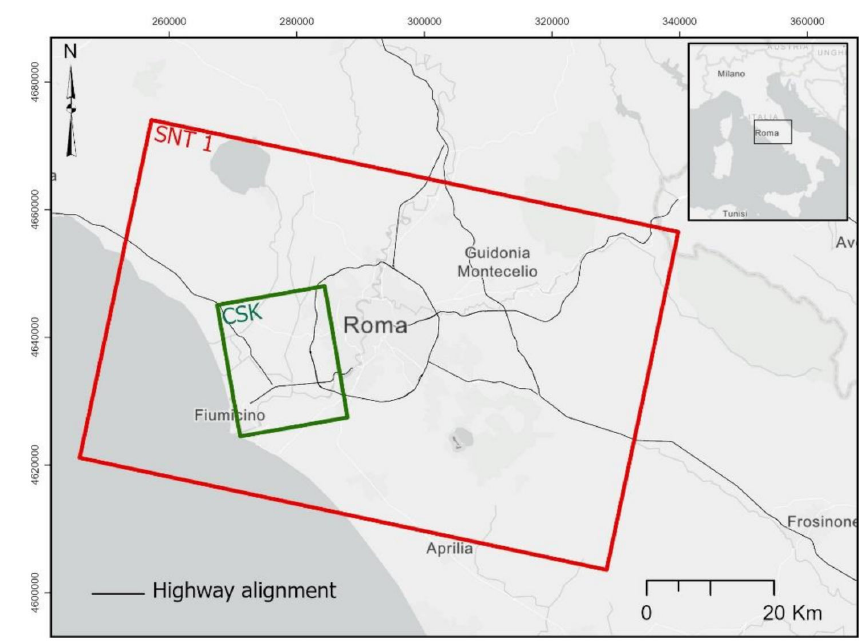
Figure 2. Area of interest and footprint of the selected Sentinel-1 tracks and Cosmo-SkyMed